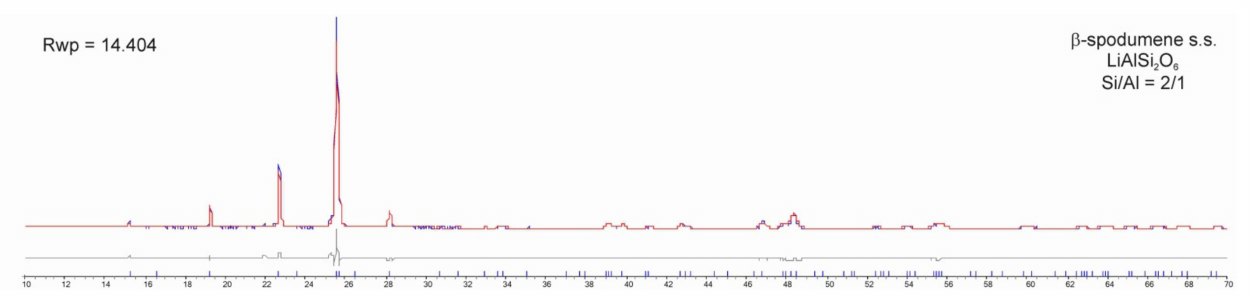
Figure A10. Example of a Rietveld refinement with single mineral composition, for sample x = 0.333 at 1200 ◦ C, experimental profile in blue, simulated profile in red, and difference in gray, with 100% β -spodumene having a = 7.53254 (4) Å and c = 9.1624 (6)